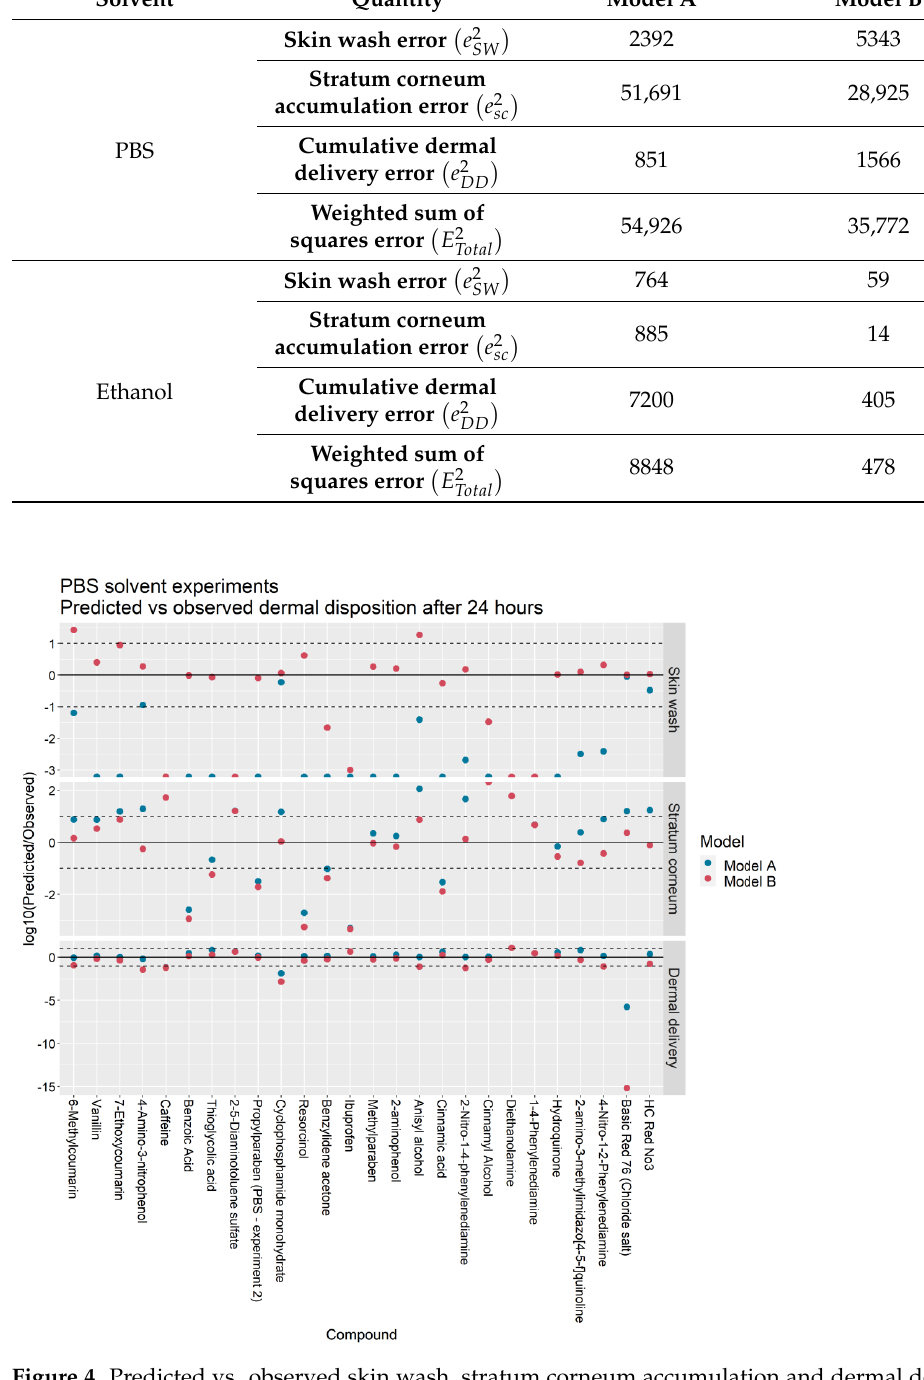
Figure 4. Predicted vs. observed skin wash, stratum corneum accumulation and dermal delivery in IVPTs conducted in a PBS solvent for Models A and B. Points between the dashed lines indicate predictions that are within one order of magnitude of observations.